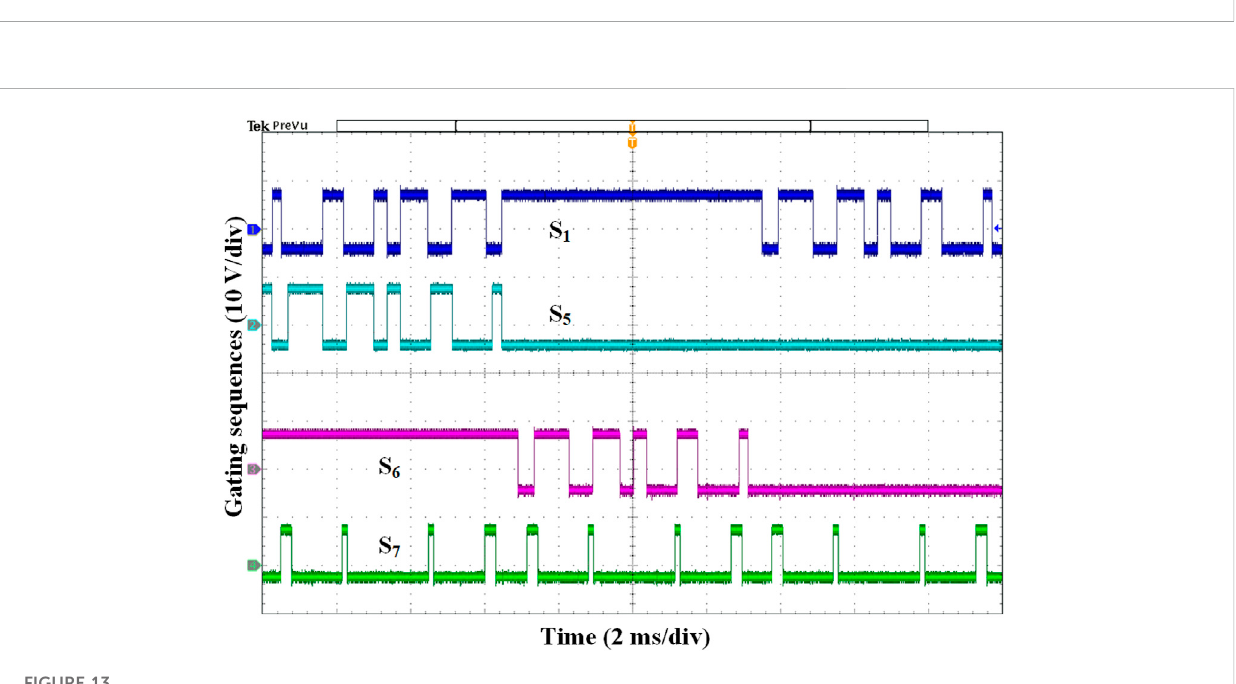
Experimental gating pulses